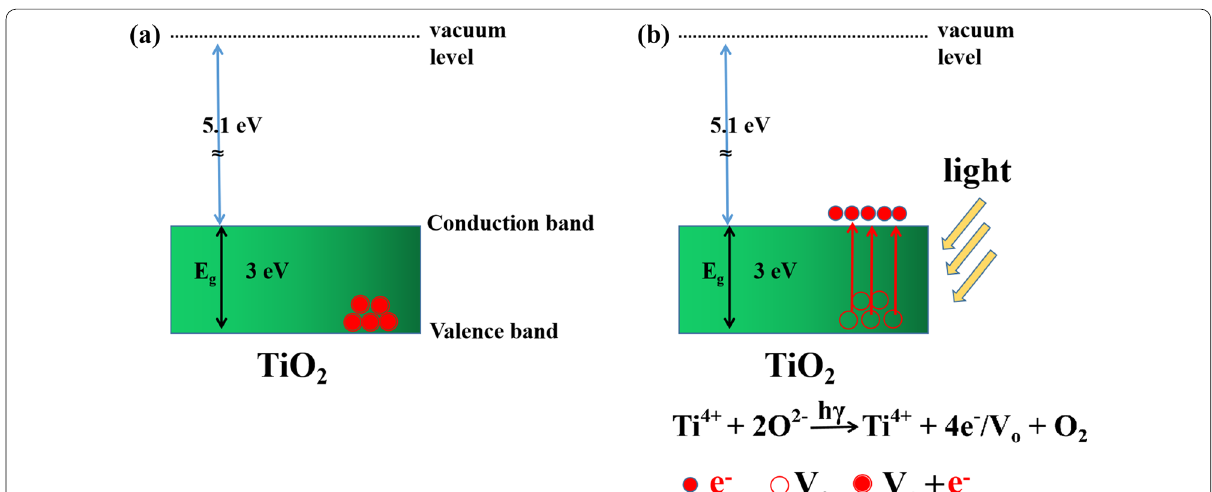
Fig. 6 Light‑tunable mechanism of the device. a Energy band diagram of TiO 2 film. b Formation of V O2 + in TiO 2 film under the illumination of